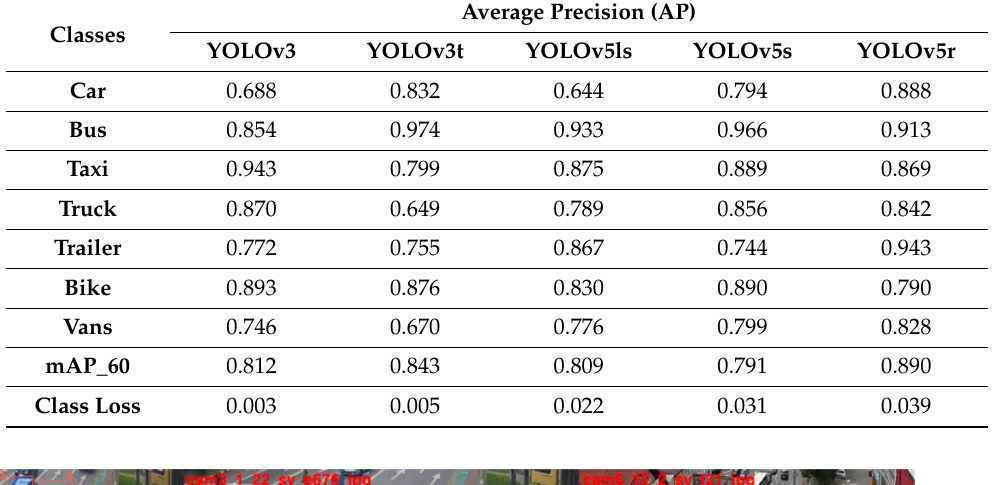
Table 4. Performance of YOLO networks for SR1 training sets and their evaluation and validation.